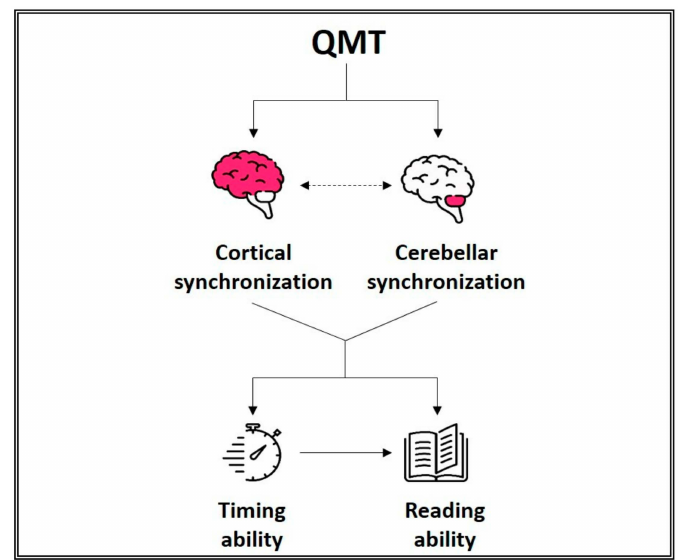
Figure 3. The potential mechanisms by which QMT improves reading ability. QMT increases cortico-cerebellar synchronization that, in turn, leads to both a direct improvement in reading ability and an indirect improvement in reading ability through enhanced timing ability (this indirect pathway still requires